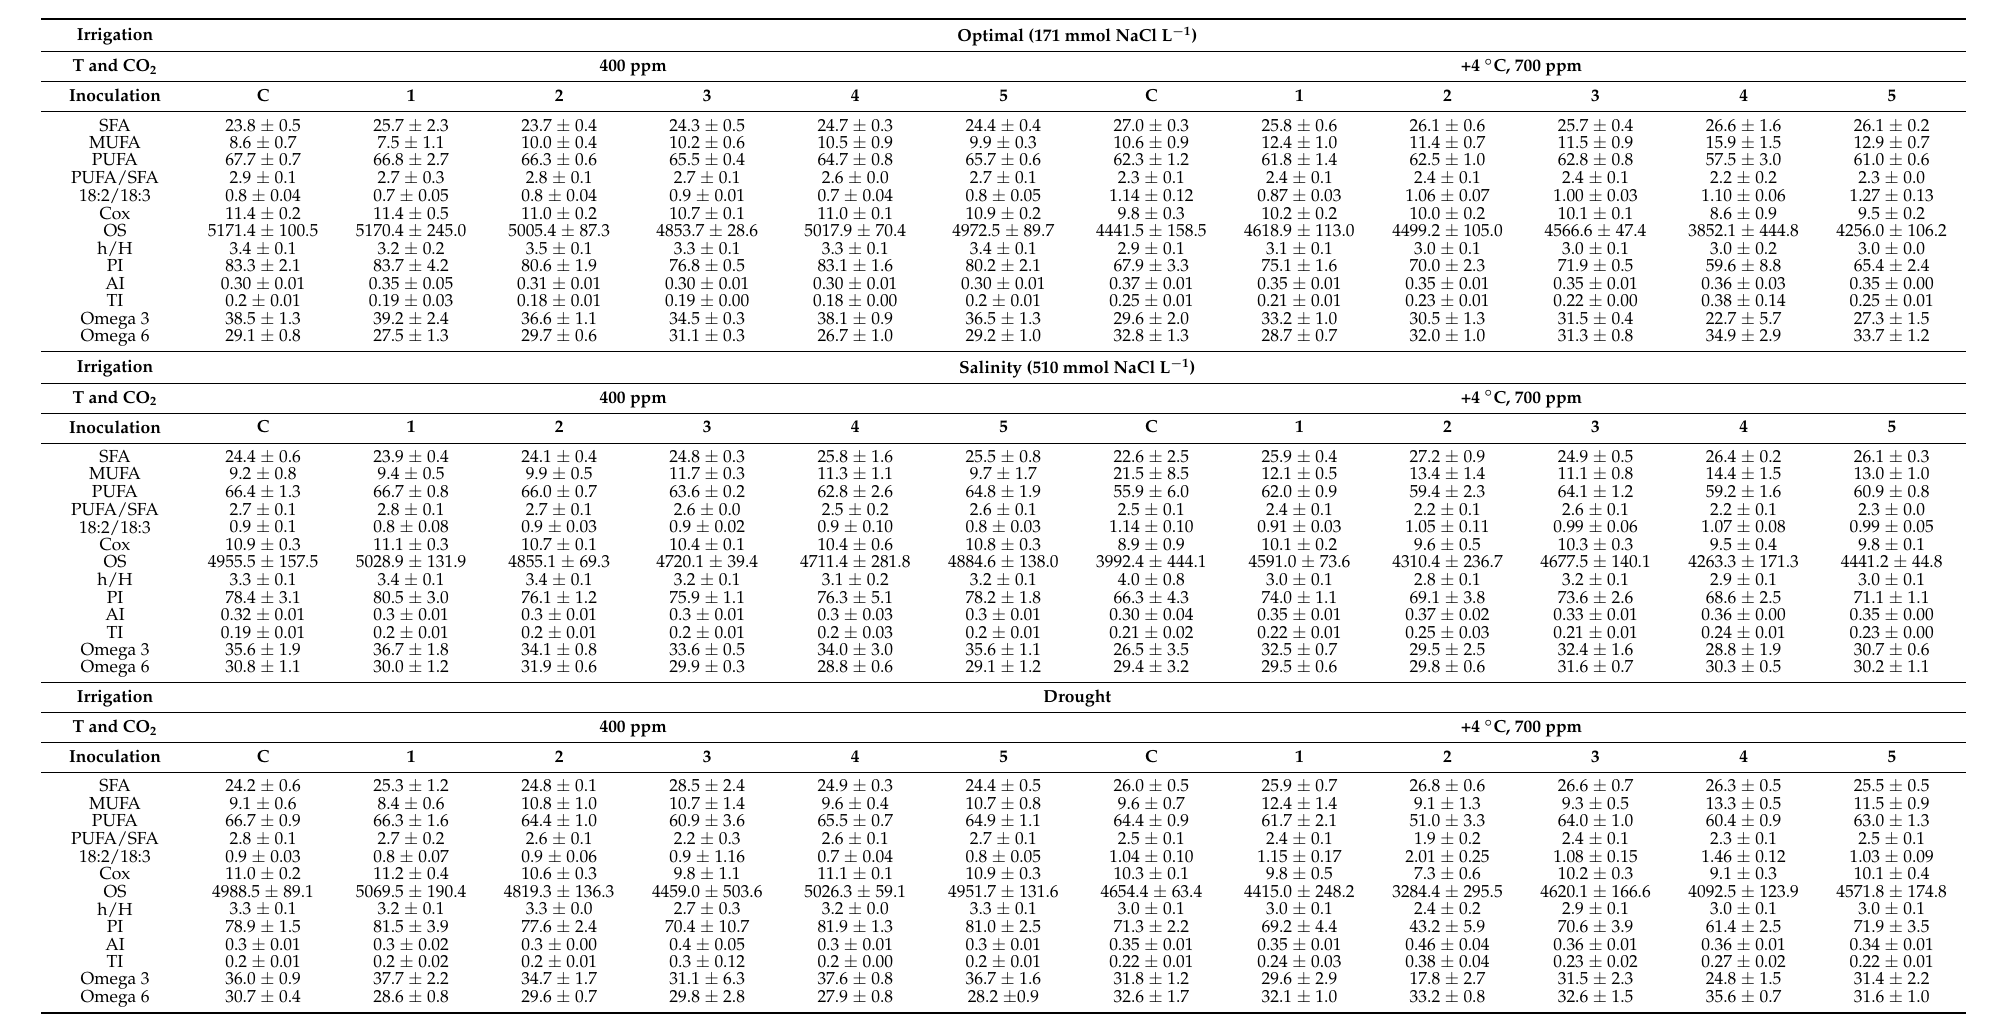
Table 1. Fatty acids for S. ramosissima shoots after 30 days of the experiment: saturated FA (SFA), monounsaturated FA (MUFAs), polyunsaturated FA (PUFA), and indexes of lipid nutritional quality: oxidizability (Cox), oxidative susceptibility (OS), hypocholesterolemic/hypercholesterolemic (h/H), peroxidizability